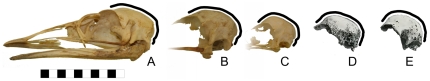
Comparison of the cranium contour in modern and King Island Emu.Several (partial) skulls from modern Emu are shown at different stages in their development: A – Adult, B – Immature-Adult, C – Juvenile. Two partial skulls are shown for the King Island Emu D & E [8]. The black lines indicate the contour of the upper/rear surface of the cranium. The adult and immature-adult modern Emu show a frontally flattened cranium, whereas King Island Emu show a more dome shaped cranium. Initially this difference was considered a species level difference, but juvenile modern emu show the same dome shaped cranium in both taxa and therefore appears not to be taxonomically significant.